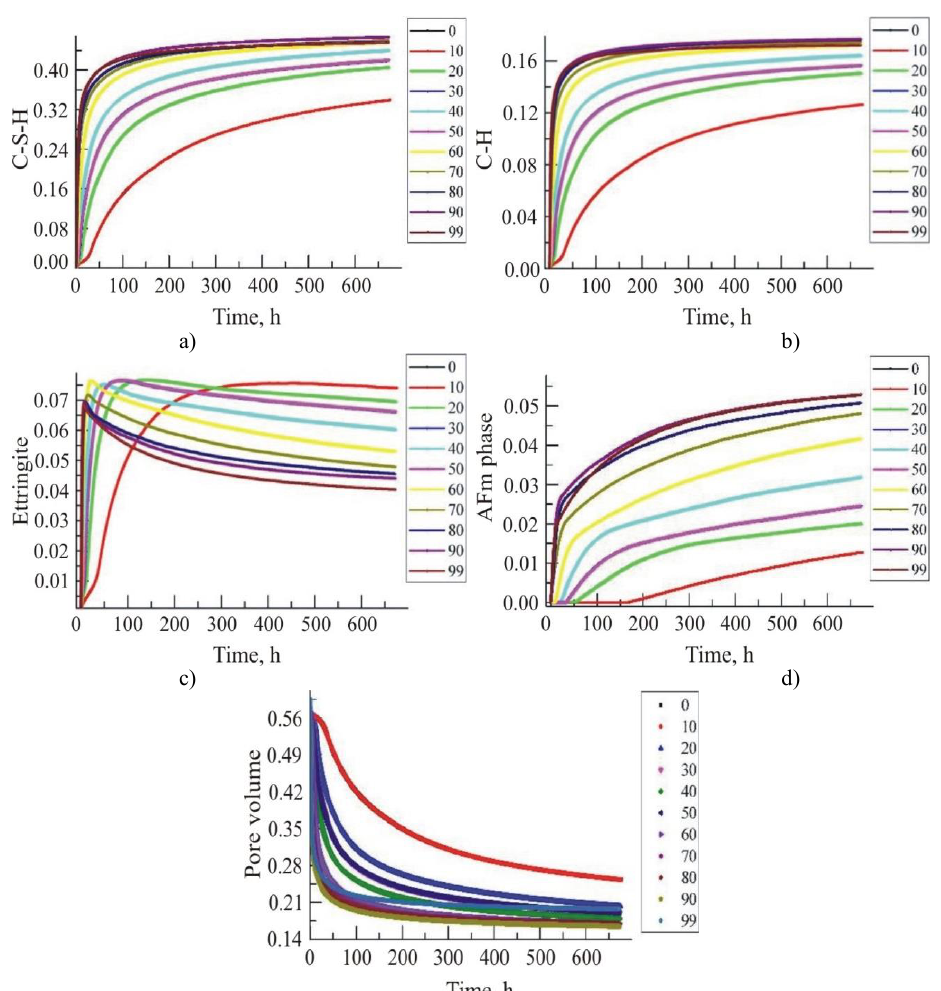
Fig. 3 . Time dependencies of hydration products and pore volume: a – C-S-H; b – portlandite; c – ettringite, d – monosulfate (AFm phase); e – pore